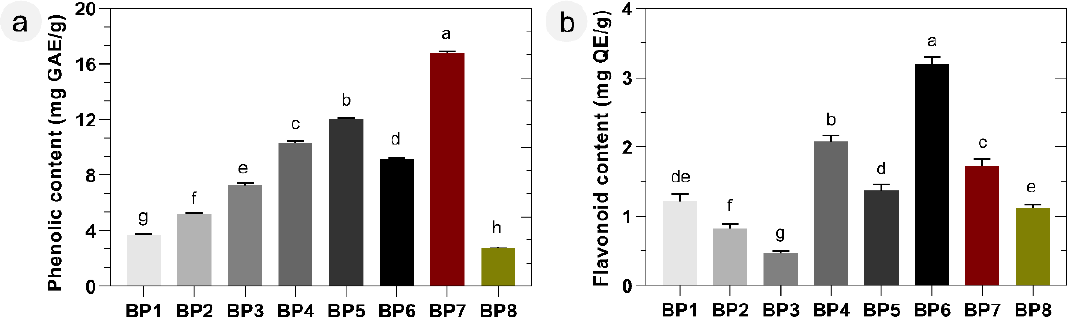
Figure 1. ( a ) Phenolic content and ( b ) flavonoid content of mono ‐ and polyfloral bee pollen samples. Different letters (a–h) indicate significant differences on the phenolic content ( p < 0.05).